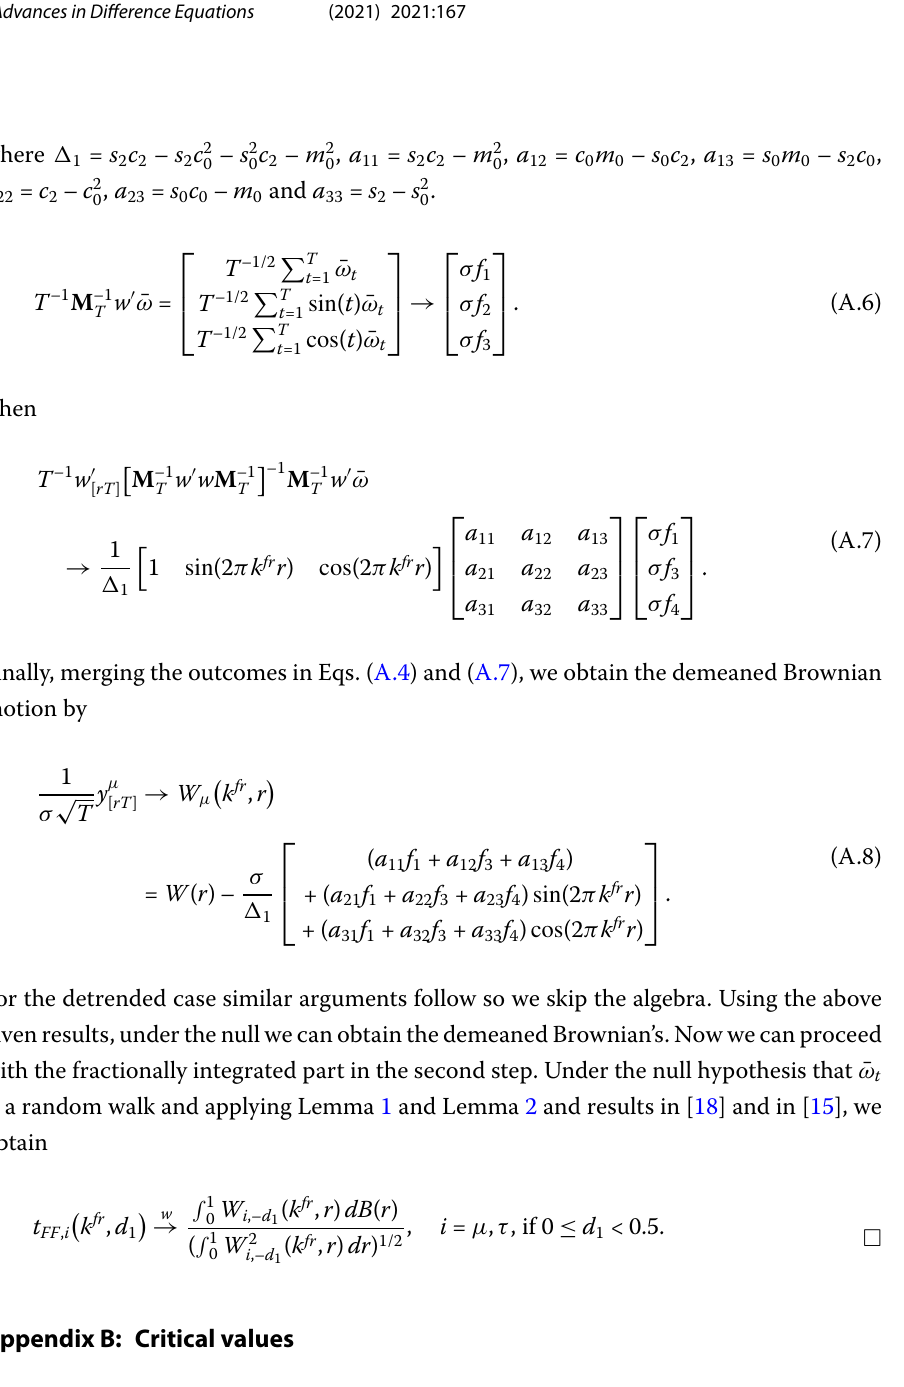
Table B1 Critical values for FI models only intercept included in fractional frequency Fourier function d = (0.1,0.5)